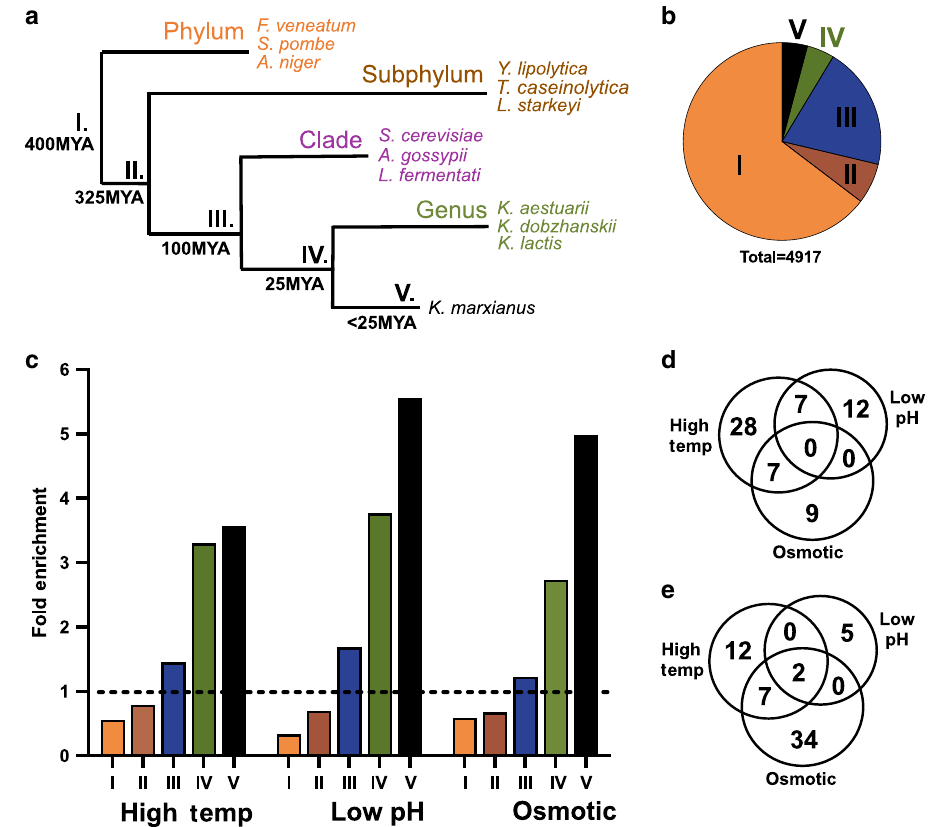
Fig. 3 Stress adaptation responsive genes in K. marxianus are enriched for young genes. a A simpli fi ed phylogenetic tree for K. marxianus showing speciation events and organisms used in orthology queries. b The transcripts detected via RNAseq from this study were grouped based on ortholog presence in the groups shown (described in detail in Supplementary Fig. 4). c Differentially expressed genes for K. marxianus were parsed by their grouping shown in a and b , then normalized to the group size and the total measured DE % (dashed line). Transcripts in groups IV and V were assessed for shared upregulated genes ( d ) or downregulated genes ( e